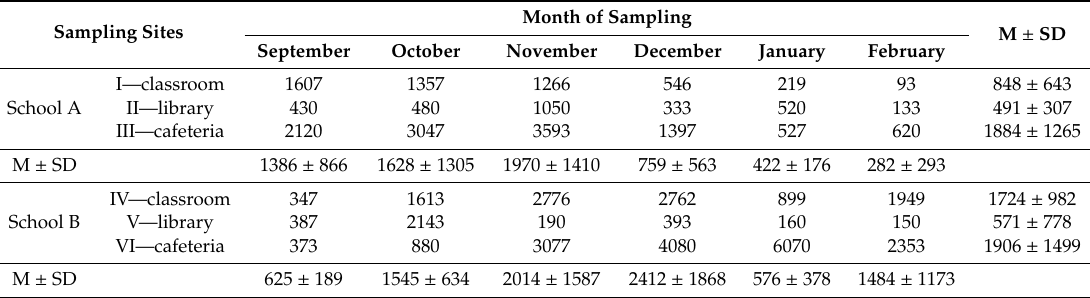
Table 2. Number of heterotrophic bacteria in air (CFU m − 3 Table 2 . Number of heterotrophic bacteria in air (CFU m − 3 ).